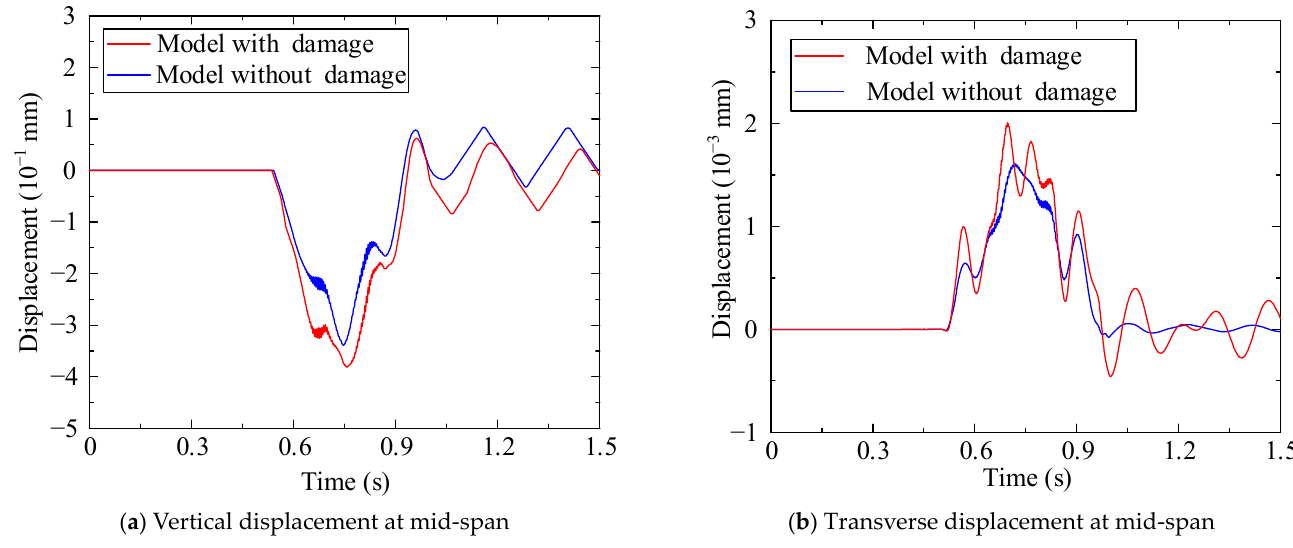
Figure 23. Responses of the composite beam at a train speed of 360 km/h in the case of T-1.